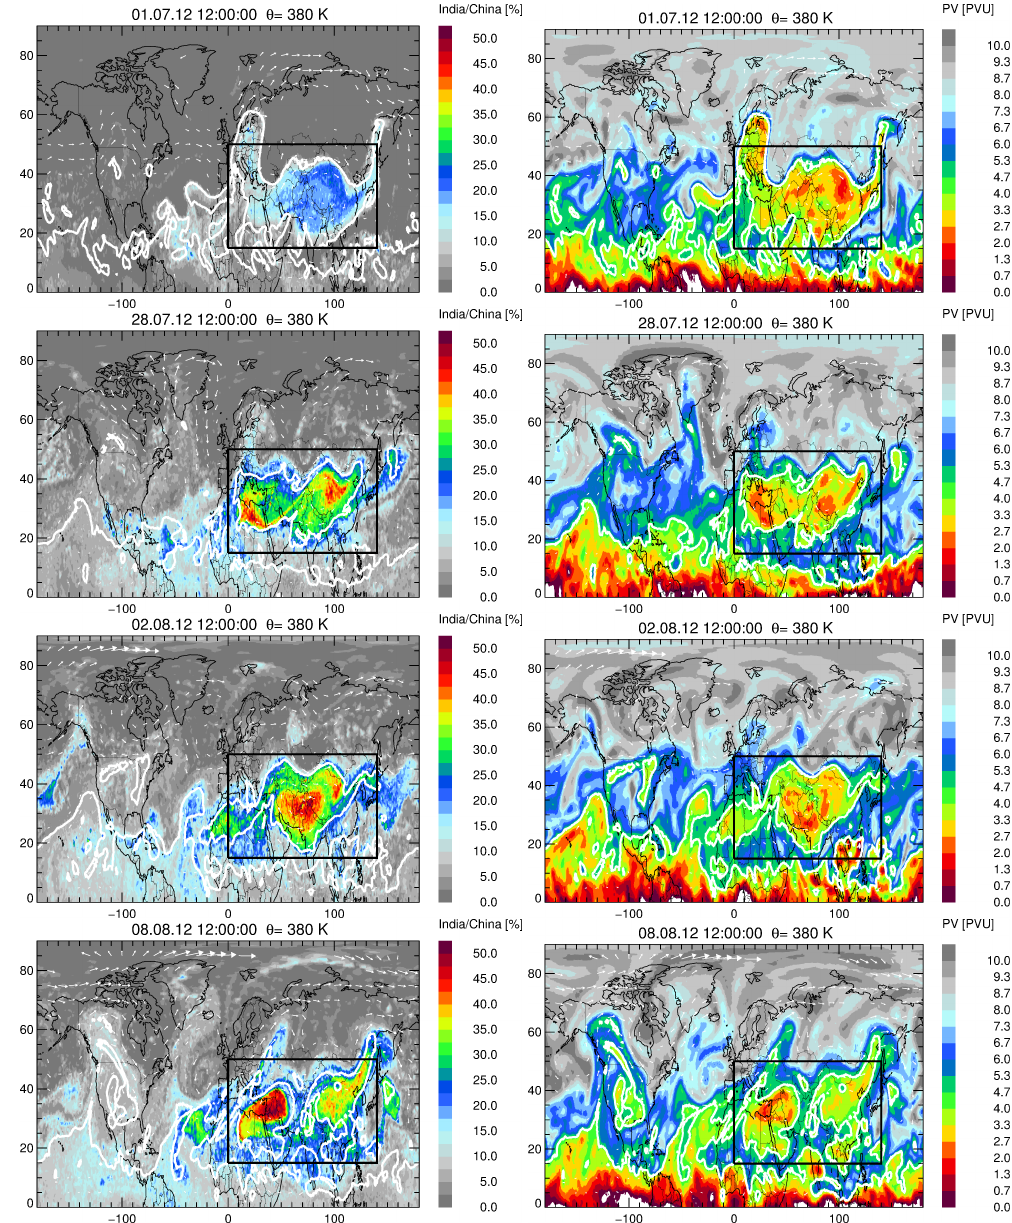
Figure 2. The horizontal distribution of the fraction of air originating in India/China (left) and PV (right) at 380K potential temperature over Asia on 1 July 2012 (top), 28 July 2012 (second row), 2 August 2012 (third row), and 8 August 2012 (bottom). Please note that the order of the colour scale for India/China (left) and PV (right) is different, so that high contributions of emission tracers for India/China and low PV are marked in red. The horizontal winds are indicated by white arrows. The black rectangle (15–50 ◦ N, 0–140 ◦ E) highlights the region of the Asian monsoon anticyclone. The 4.5PVU surface marks roughly the edge of the anticyclone shown as a thick white